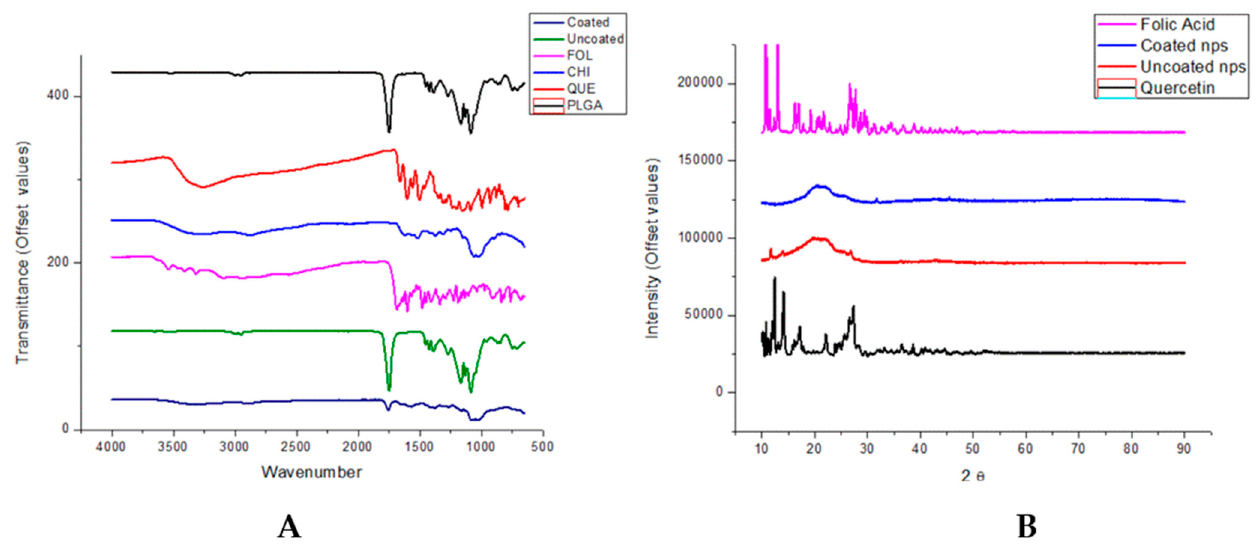
Figure 5. ( A ) FTIR spectra of uncoated and coated nps and pristine polymers where Fol = folic acid, Chi = chitosan, and Que = quercetin. ( B ) XRD spectra of Quercetin and uncoated and coated nano- particles.